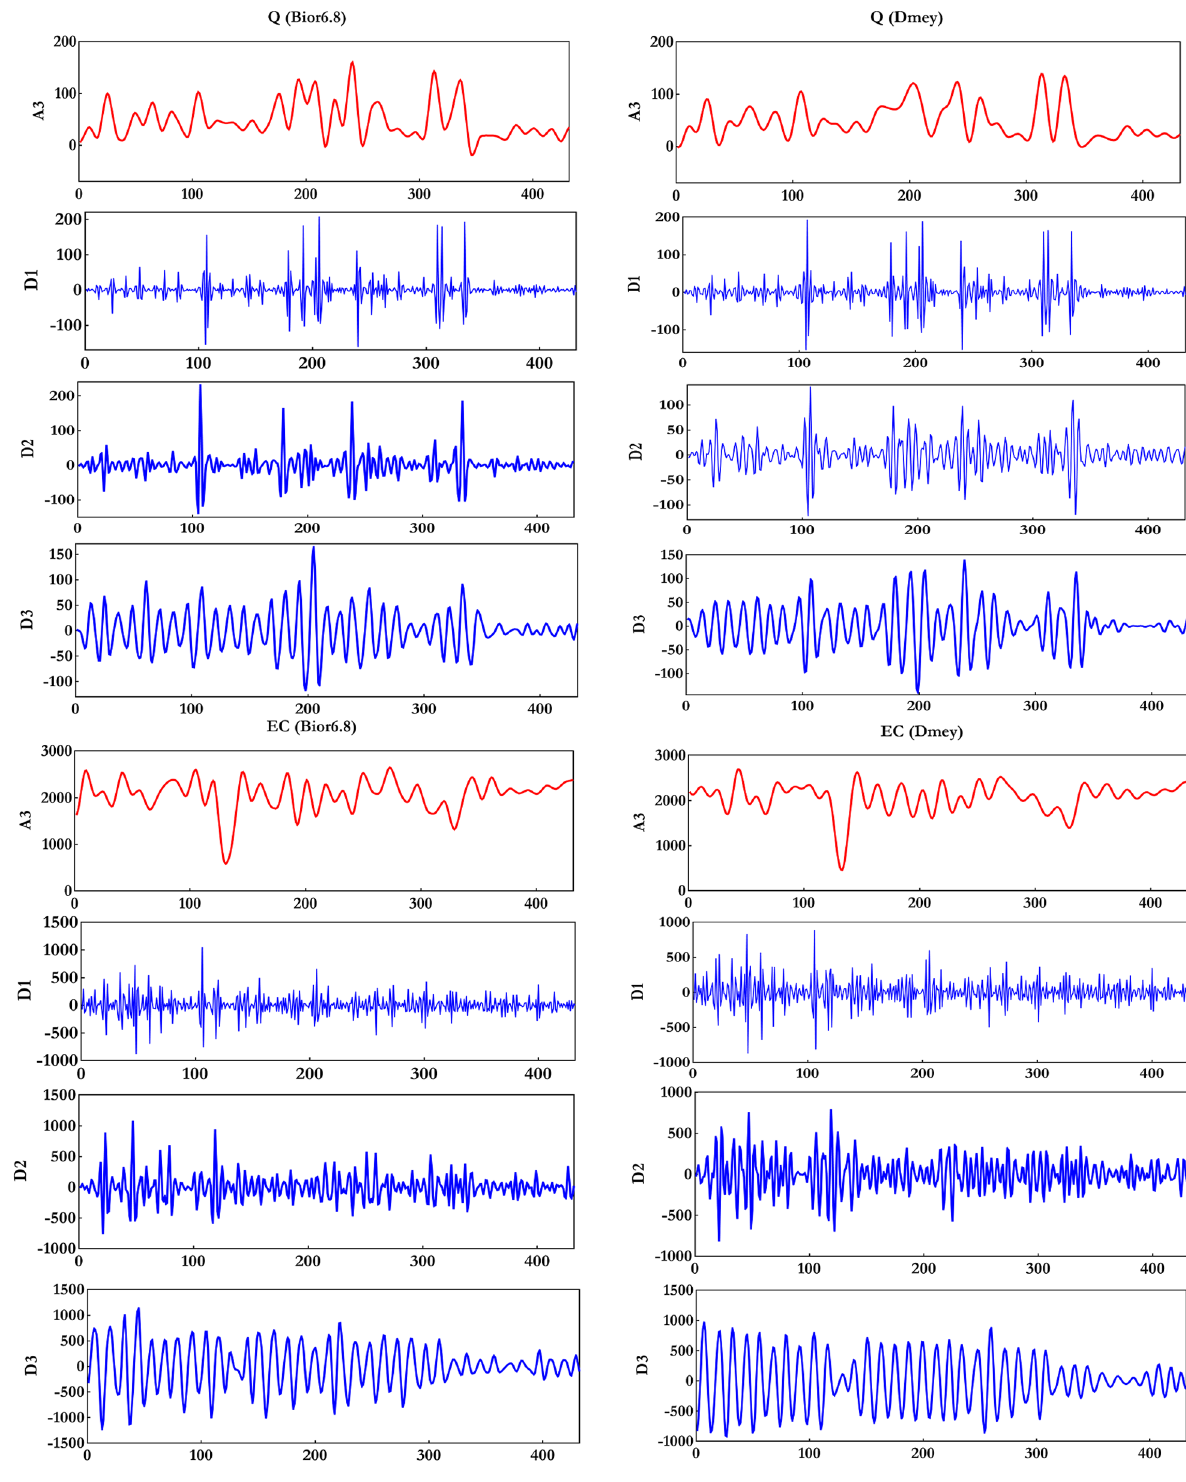
Figure 8. Decomposition of Q and EC datasets for two mother wavelets (Bior6.8 and